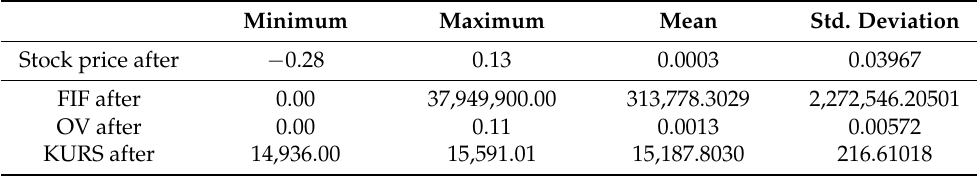
Table 13. Descriptive Statistics After Lockdown.